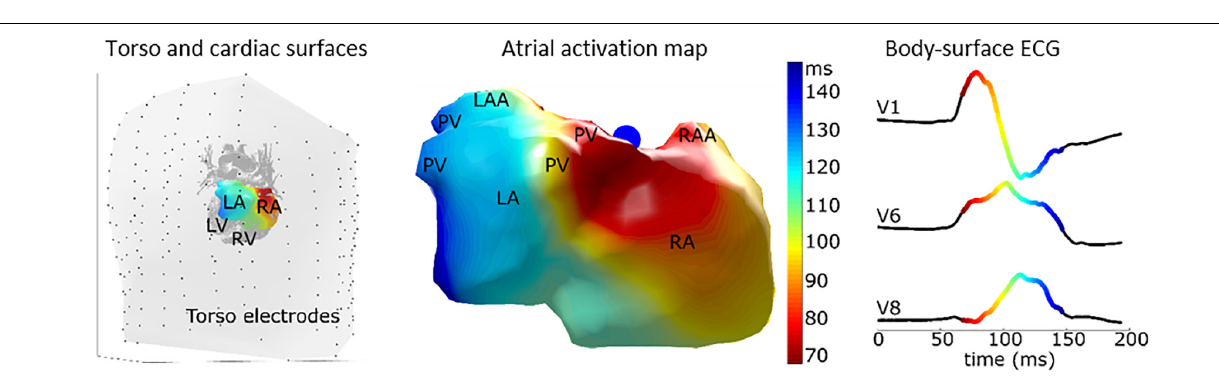
FIGURE 8 | Epicardial activation pattern of an individual without a history of AF, highlighting the level of detail with which the activation pattern can be studied on the atria to better understand normal patterns and diseased patterns that may reflect AF substrate. The left panel shows the torso electrodes (black dots) and torso (gray surface) with cardiac structures inside. The middle panel shows the atrial epicardial activation sequence as mapped with Electrocardiographic imaging (ECGI). The right panel shows corresponding body-surface P-waves of leads V1, V6, and V8. LA, left atrium; RA, right atrium; LV, left ventricle; RV, right ventricle; PV, pulmonary vein; LAA, left atrial appendage; RAA, right atrial appendage. Figure modified from Lankveld